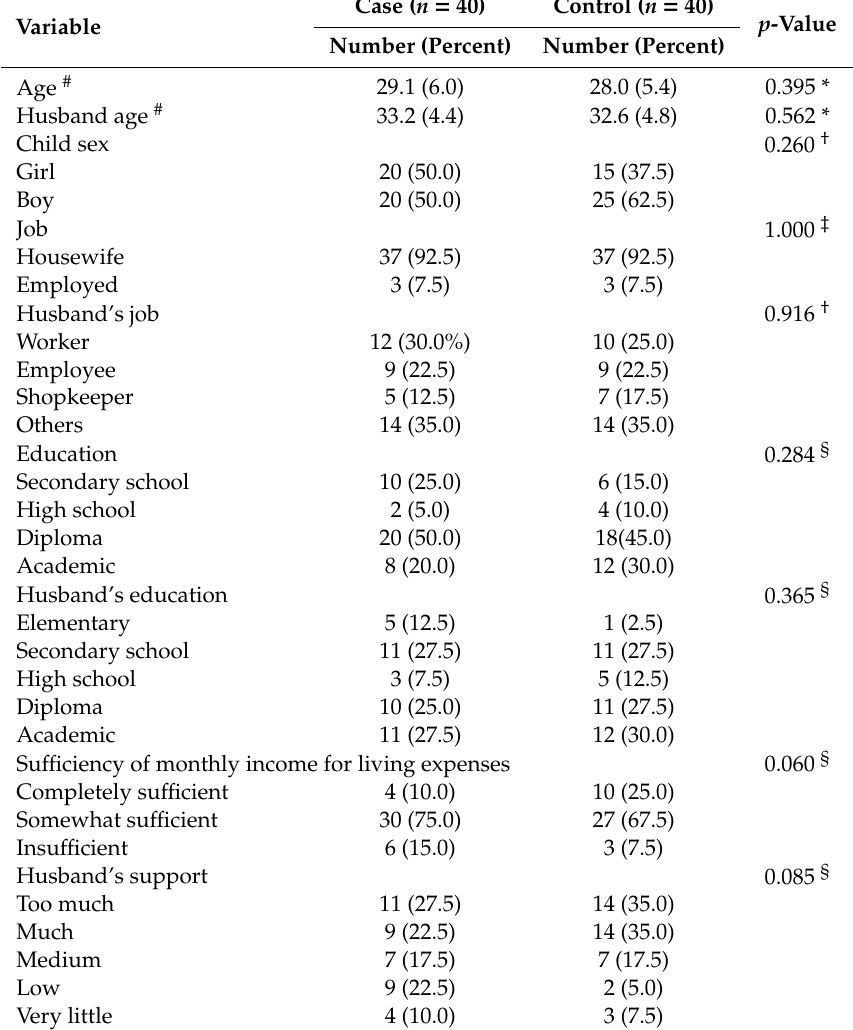
Table 1. Sociodemographic and obstetrics characteristics in the study